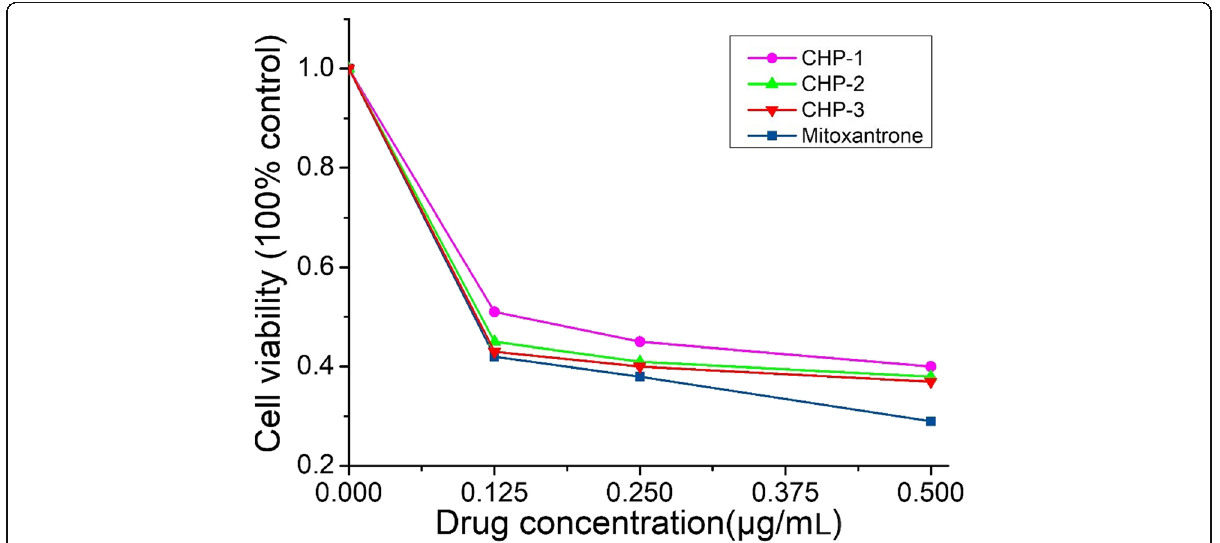
Fig. 5 Cytotoxicity of free mitoxantrone and mitoxantrone-loaded CHP NPs at 24 h (blue square: mitoxantrone, pink circle: CHP-1, green triangle: CHP-2, red down-pointing triangle: